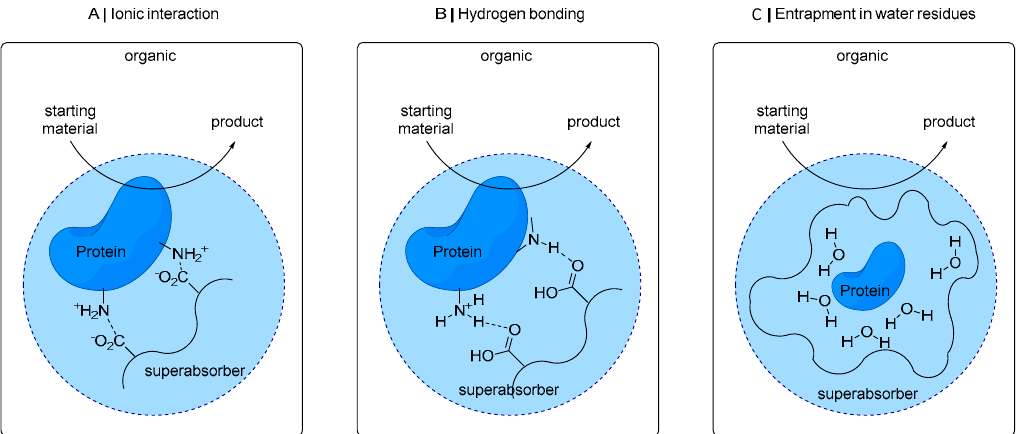
Figure 1. Scheme of superabsorber-based enzyme immobilization based on ionic interactions of acetate moieties of the superabsorber polymer particles and amino acid residues on the protein surface ( A ), hydrogen bonds of, for example, amino acids with carboxylic polymer residues ( B ), or entrapment of protein in water residues bound in the polymer matrix ( C ). Immobilized enzyme converts starting material dissolved in surrounding organic solvent to product, diffusing back into the organic solvent. The light blue circle with dashed line illustrates superabsorber particles with polymer network indicated as wavy lines in the surrounding organic solvent.